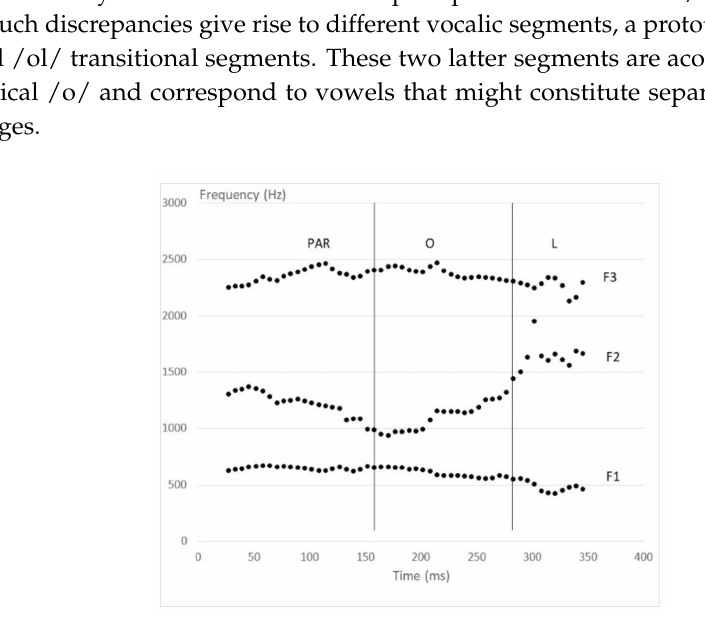
Figure 2. Formant frequencies (Praat © [17], version 6.0.37) in the word /paRol/ produced by a French speaker. The vertical lines correspond to the perceptual limits between the / R o l / segment and the initial (PAR) and final (L) parts of the word. F1, F2, F3 correspond to formants one, two and three,